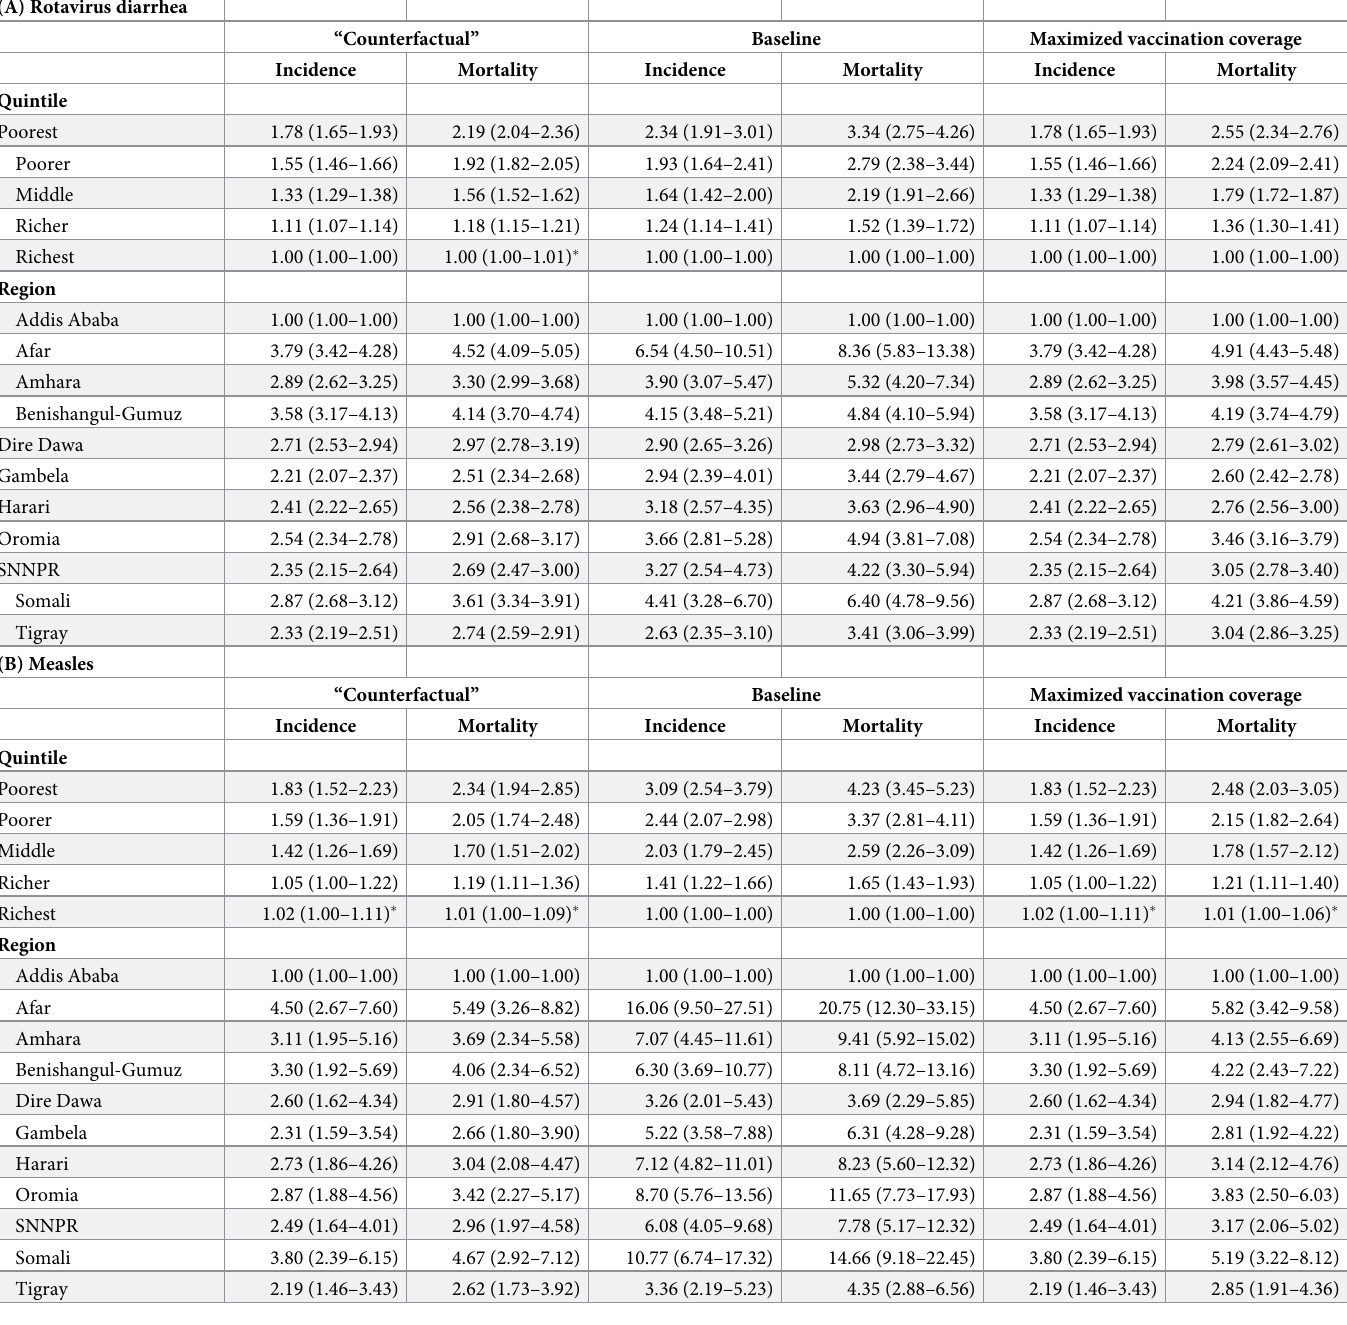
Table 3. Estimated relative risk distribution of (A) rotavirus diarrhea incidence and mortality, (B) measles incidence and mortality, (C) pneumonia (pneumococcal and Hib) incidence and mortality, and (D) HPV incidence across three scenarios by wealth quintile and geographic region. The three scenarios include the distribu- tion of risk and prognostic factors. The “counterfactual” scenario presents a scenario without vaccination or treatment-seeking behavior, the baseline scenario presents a scenario with current vaccination coverage and treatment-seeking behavior, and the maximized vaccination coverage scenario presents a scenario in which vaccination coverage in all population subgroups is increased to the level of vaccination coverage of the subgroup with the greatest vaccination coverage (e.g., all quintiles are modeled as having the same level of vaccination coverage as the richest